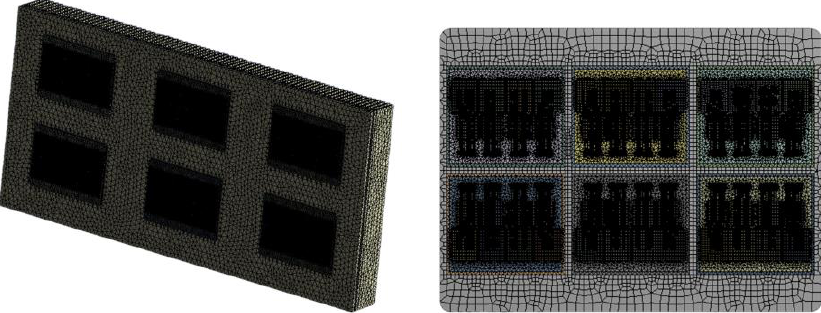
Figure 3. Mesh division of the